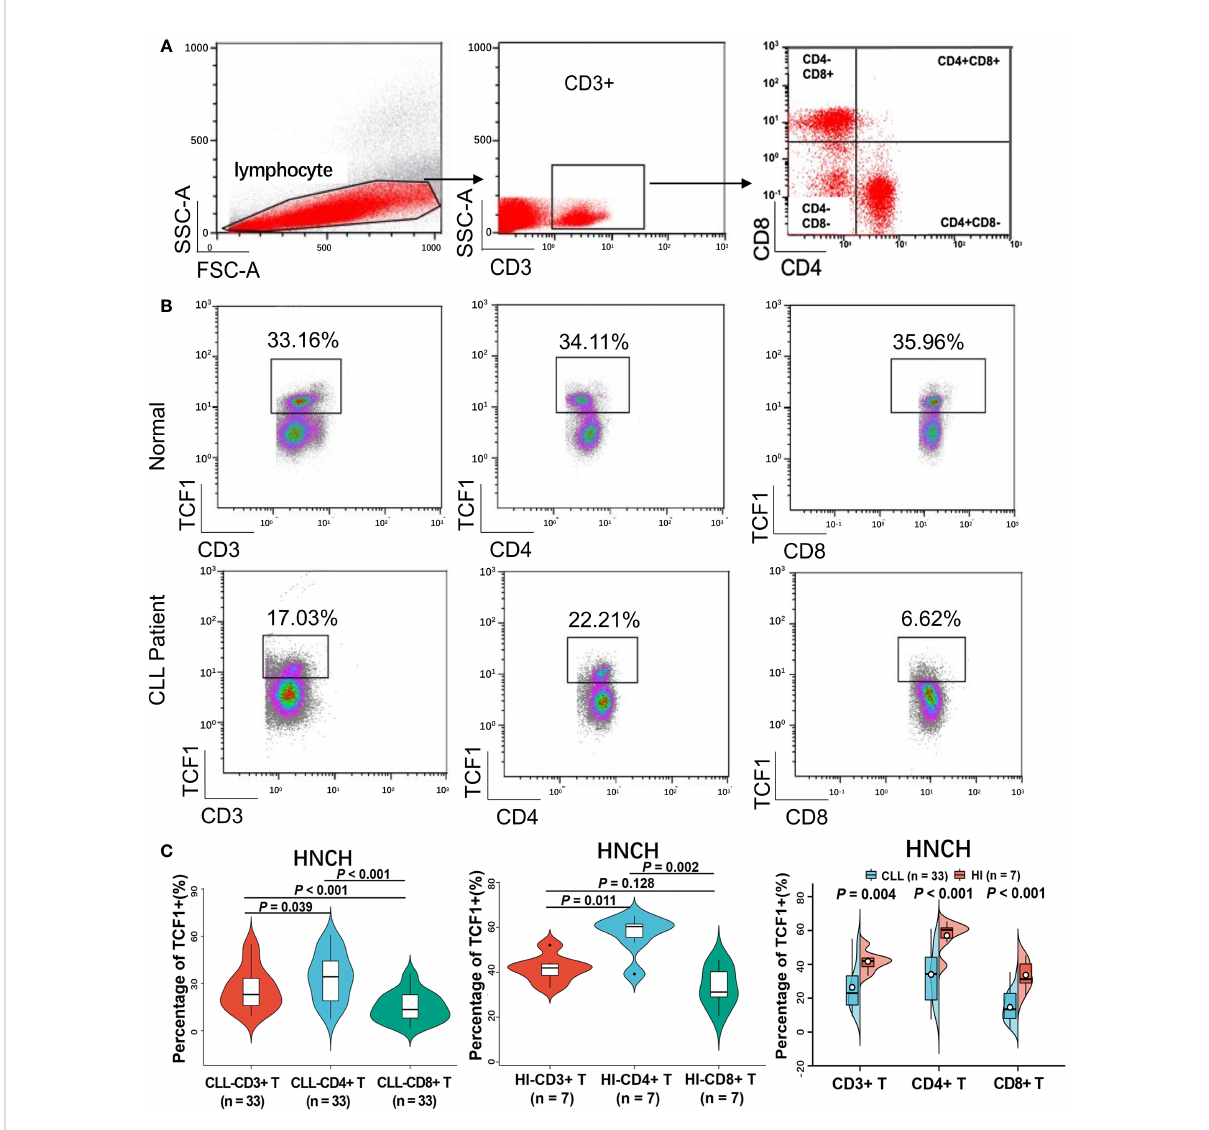
FIGURE 6 The percentage of TCF1+ cells on various T cell subgroups of CLL and HIs. (A) Flow cytometry gating strategy. (B) Representative pro fi les of TCF1 expression on CD3+, CD3+CD4+, and CD3+CD8+ T cells in HIs (top) and CLL patients (bottom). (C) The expression of TCF1 in CD3+, CD3+CD4+, and CD3+CD8+ T cells from CLL patients and HIs in the HNCH. Error bars indicate